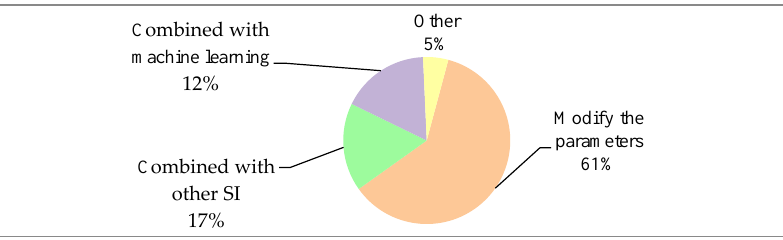
Figure 9. SI algorithm optimization methods.